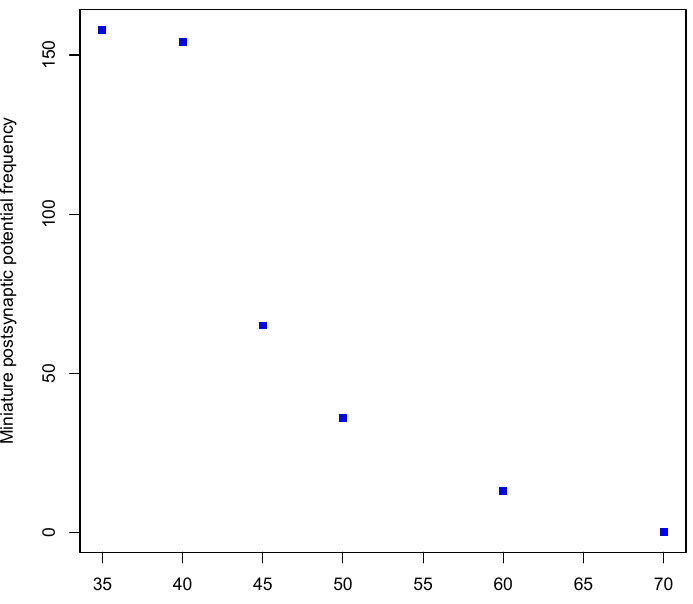
Figure 9. Time course of reduction and loss of miniature parasitism-specific proteins (PSPs) in the silk moth Philosamia cynthia following injection of H. hebetor venom (Source: data from [184]). Thus, the data indicate that the main process involved in the venom-induced paral- ysis is the block of exocytosis of presynaptic neurotransmitter (L-glutamate) vesicles [162,181,185,186]. A putative endonuclease (34 kDa) and two putative phospholipases (phospholipase